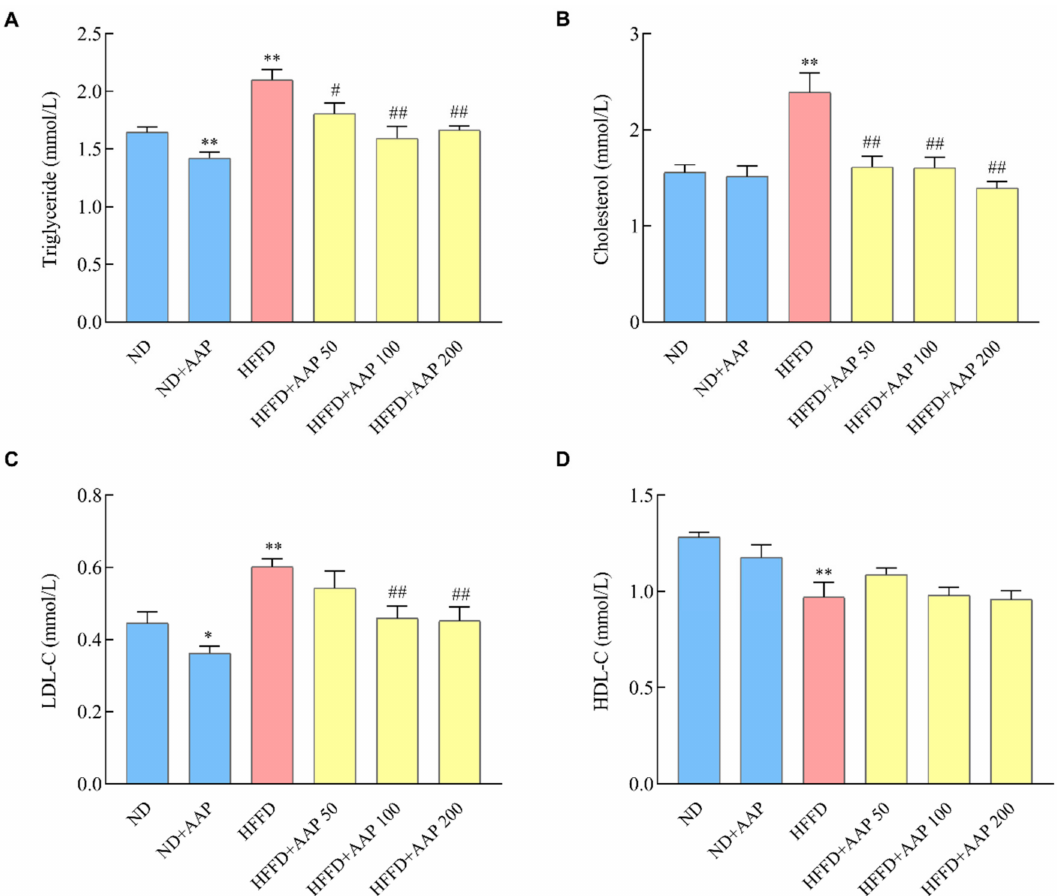
Figure 4. Effects of Auricularia auricula-judae polysaccharides on serum lipid levels in the HFFD- induced obese mice. ( A ) Triglyceride levels; ( B ) total cholesterol levels; ( C ) high-density lipoprotein cholesterol levels; ( D ) low-density lipoprotein cholesterol levels. The data are presented as the mean ± SEM, n ≥ 6, * p < 0.05, ** p < 0.01, vs. ND group, # p < 0.05, ## p < 0.01 vs. HFFD